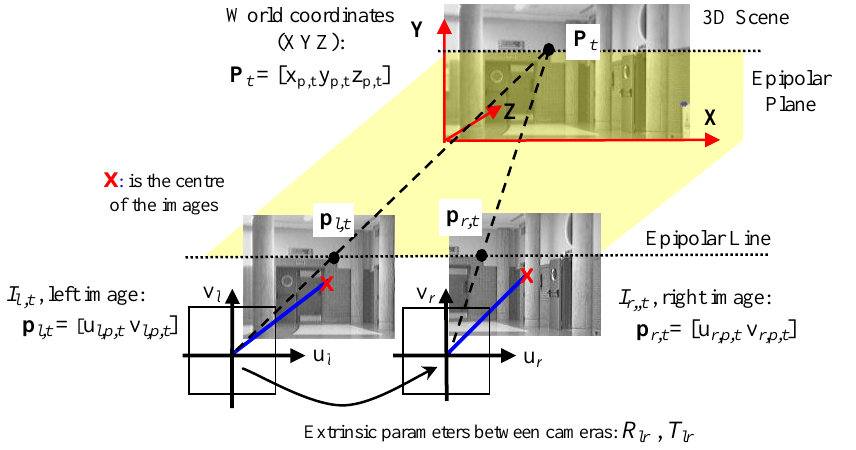
Figure 3. Functional description of the stereo vision data extraction